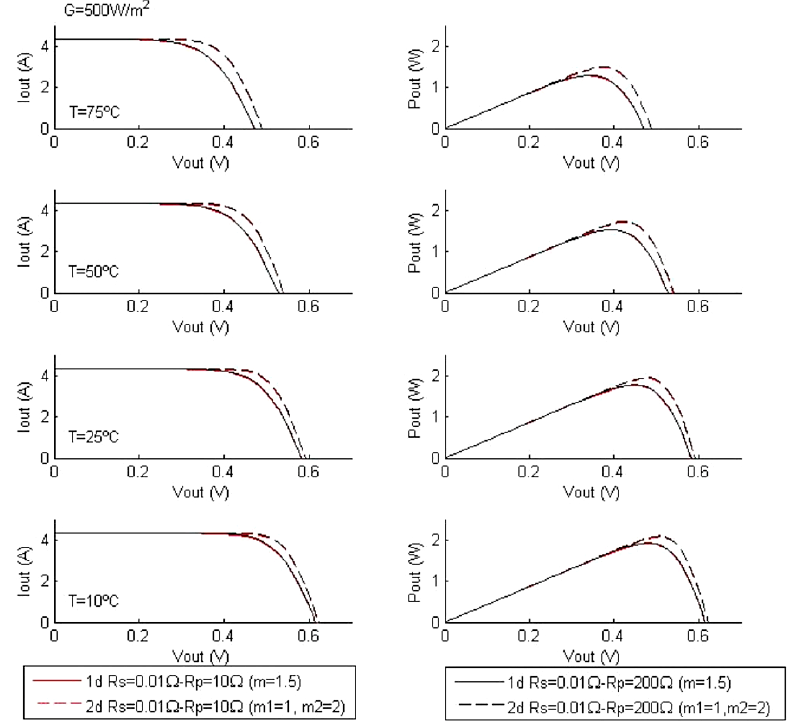
Figure 12. Characteristic curves of equivalent circuits of one and two diodes in function of temperature and parallel resistance R p , with a constant resistance R s (G = 500 W/m 2 ).